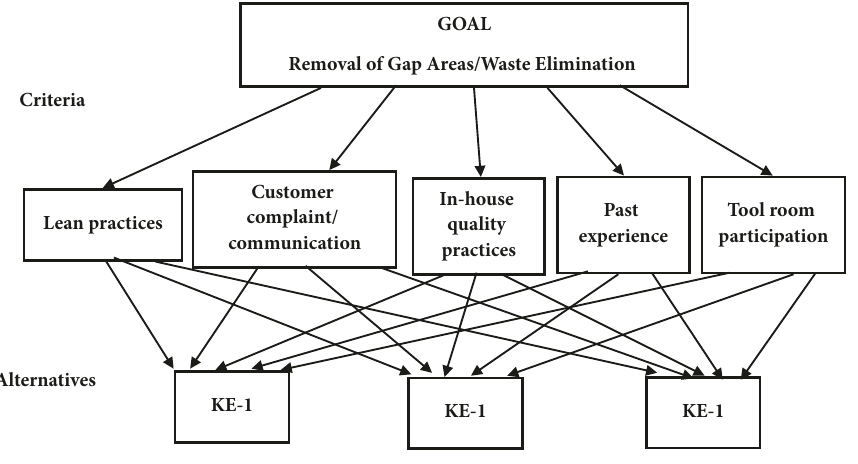
Figure 6: Structure for evaluation of Kaizen events. Table 5: Calculations for average fuzzy rating, normalized fuzzy rating, and weighted normalized fuzzy rating.